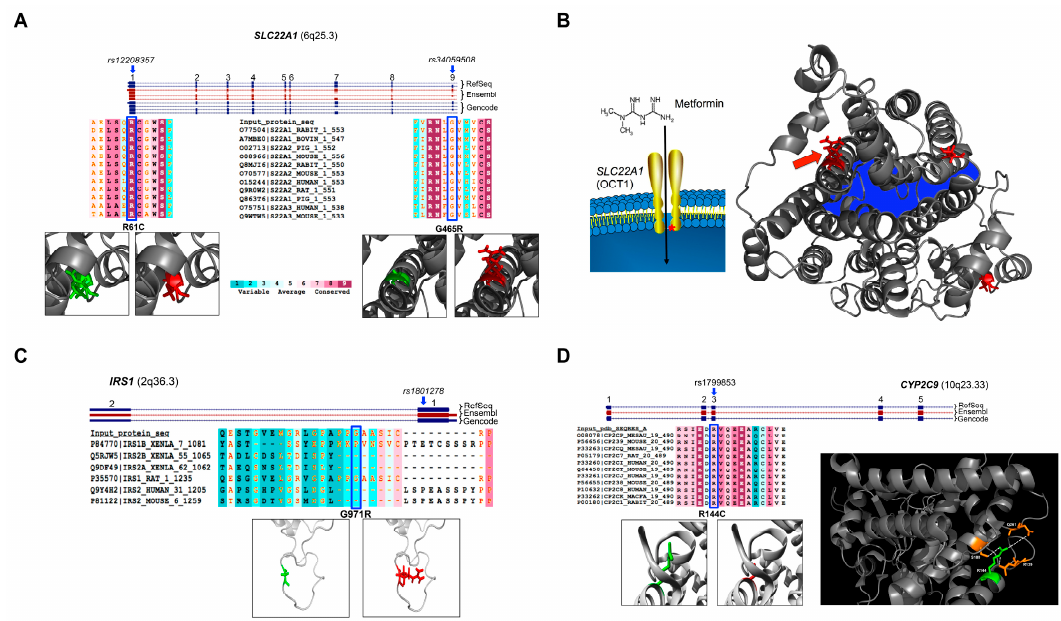
Figure 1. SLC22A1 polymorphisms associated with metformin response. In the upper part, are schematically reported the genomic localizations of the SNPs analyzed in SLC22A1 , IRS1 and CYP2C9 gene, in the panels ( A ), ( C ) and ( D ), respectively. RefSeq, Ensembl and GENCODE annotations are shown in different colors and are indicated in the Figure. The boxes indicate the exons and numbering is indicated above. The blue arrows indicate the genomic localization of the polymorphisms. In the lower part of panels ( A ), ( C ) and ( D ) are shown the 3D representations of amino acid changes corresponding to these SNPs. The canonical amino acid is reported in green and the mutated residue is shown in red. The evolutionary conservation score for each altered amino acid residue—according to Consurf software—is also shown. The specific amino acid is highlighted by a blue box; ( B ) on the left part, a schematic representation of the Oct1 protein in the cell membrane is shown. The red asterisk indicates the approximate position of the amino acid 465G, whose alteration is associated with reduced metformin responsiveness. On the right part of panel ( B ), the 3D protein structure of the entire Oct1 protein is shown. The inner portion of the channel is indicated in blue. Amino acid changes under evaluation are indicated in red (red arrow indicates G465R substitution); ( D ) on the right , the 3D protein structure of Cyp2c9 is shown, with the canonical R144 residue (in green) and three amino acids that are predicted to interact with it (in orange). Dashed white lines indicate the H-bonds among these residues.